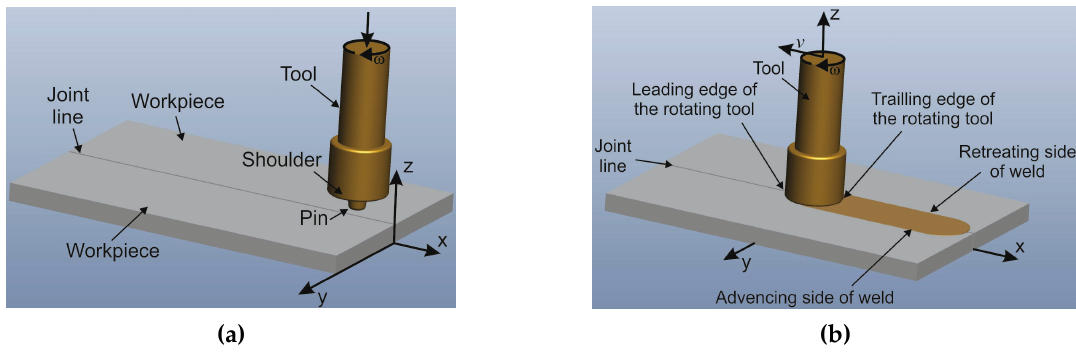
Figure 1. Performing the process Friction stir welding. ( a ) the first phase; ( b ) the second phase. As experimental research from real material is expensive, numerical experiments through the use of various software packages have shown that data obtained very successfully describes the studied process. Therefore, in a large number of published papers, numerical simulations of the FSW process are